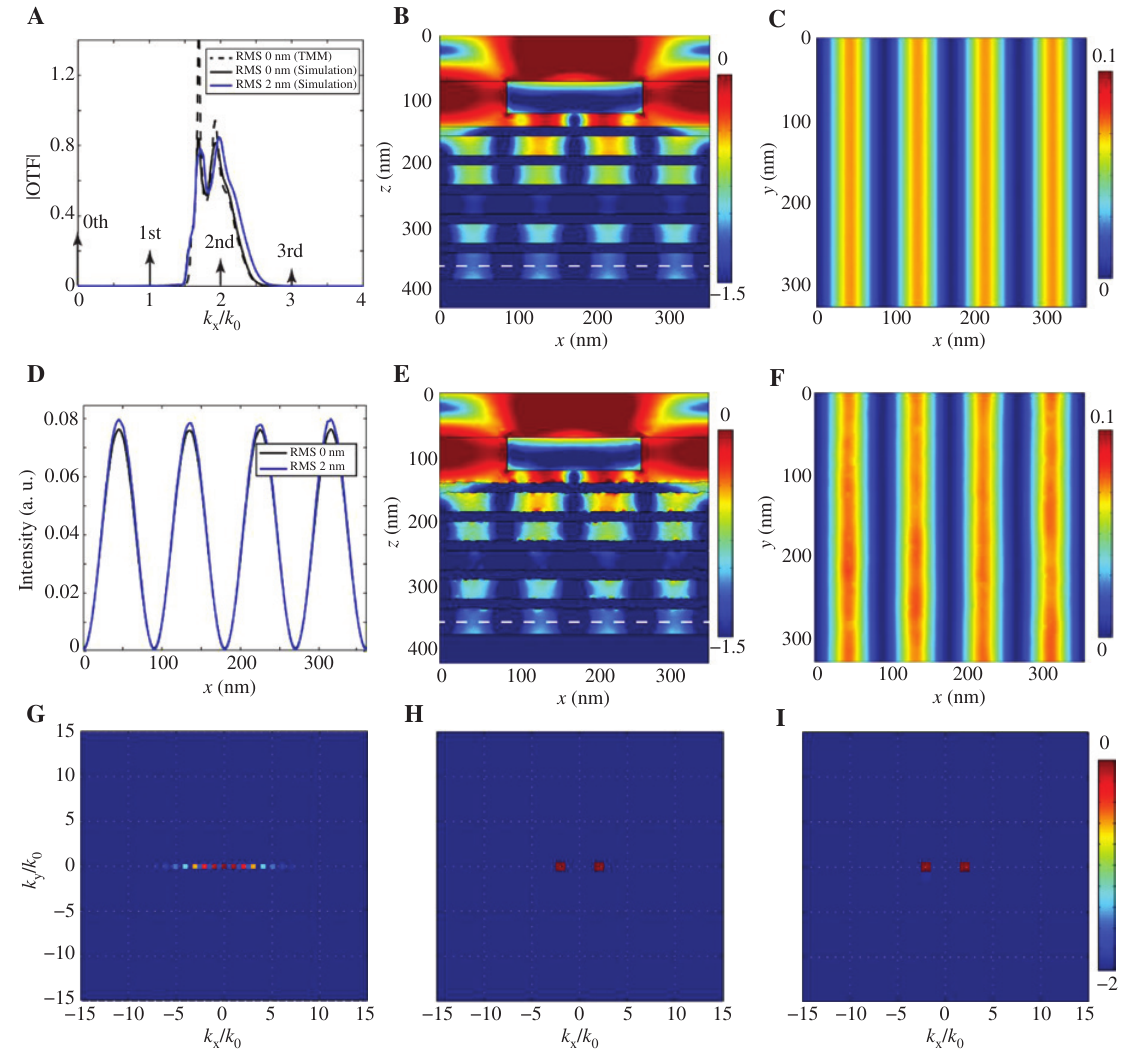
Figure 3: Effects of the rough films in HMM lithography system. (A) OTF curves of alternating nine films of Al (15 nm)/SiO (30 nm) with smooth and rough surfaces calculated by TMM and numerical simulation. 2 The arrows show the positions of diffraction orders of the grating mask in k -space. (B) Side view and (C) top view of the normalized electric field intensity distributions with a smooth multilayer (RMS = 0 nm); (E, F) corresponding simulation results with a rough multilayer (RMS = 2 nm); (D) normalized electric field intensity distribution of the patterns in the PR film at the dashed line positions in (B) and (E). (G) A series of diffraction orders in k -space generated from grating with a period of 360 nm. The distributions of diffraction orders in the PR film after transmitted through the multilayer with the roughness of (H) 0 nm and (I) 2 nm, respectively. The logarithm scale is used in (B), (E) and